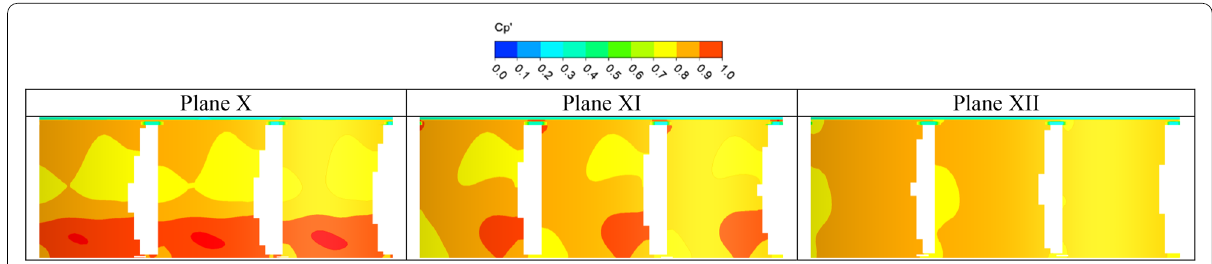
Figure 21 Distributions of pressure pulsation intensity coefficients on radial